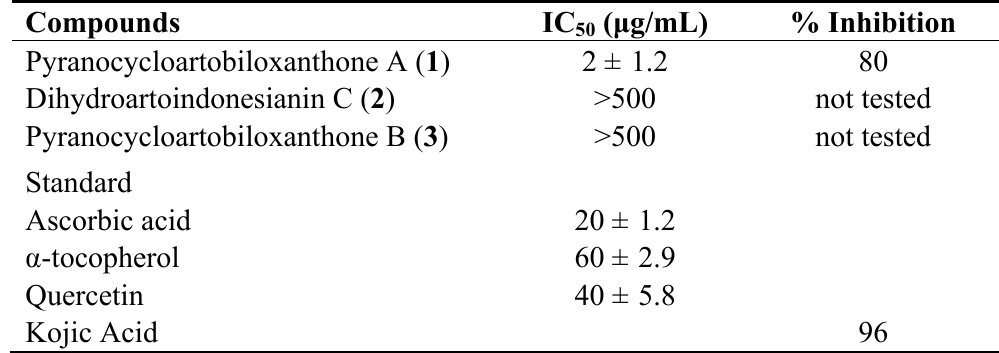
Table 1. The IC values of the pyranocycloartobiloxanthone A ( 1 ), dihydroartoindonesianin 50 C ( 2 ) and pyranocycloartobiloxanthone B ( 3 ) against DPPH (free radical) and percentage inhibition of